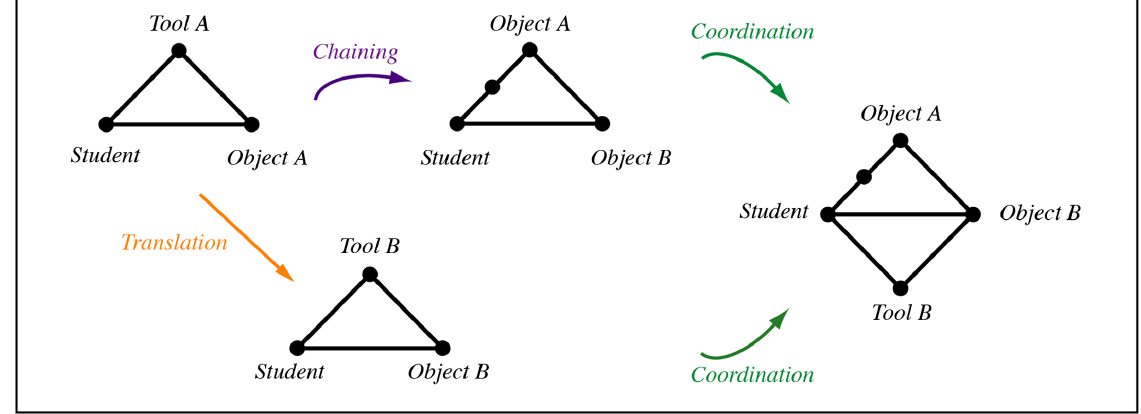
FIG. 6. An example of a sense making diagram. These diagrams show the individual atoms of reasoning as well as the processes by which they come together to form a molecule of sense making. Each individual shape (triangle, triangle with node, square, etc.) represents a unique reasoning structure , which can be either a local instance of a single mode, or be built up of many modes through the processes of translation, chaining, and